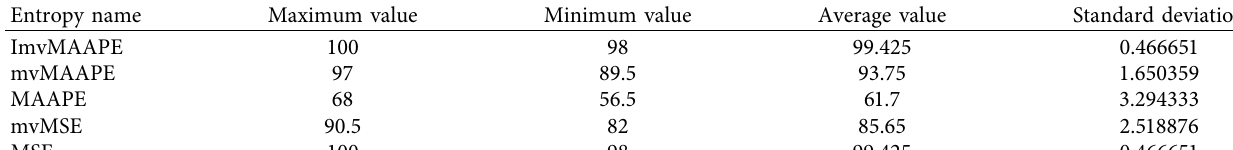
Table 6: The bearing experiment results of different entropies.